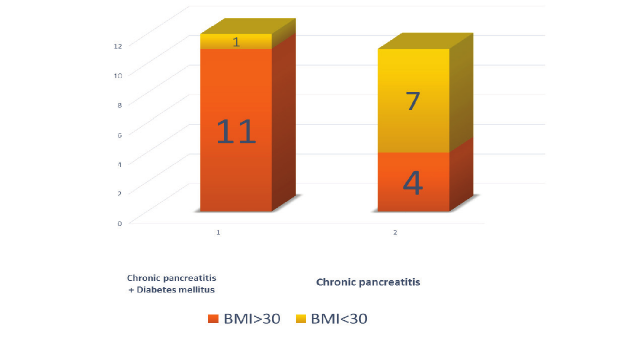
Figure 3 - The body mass index in patients